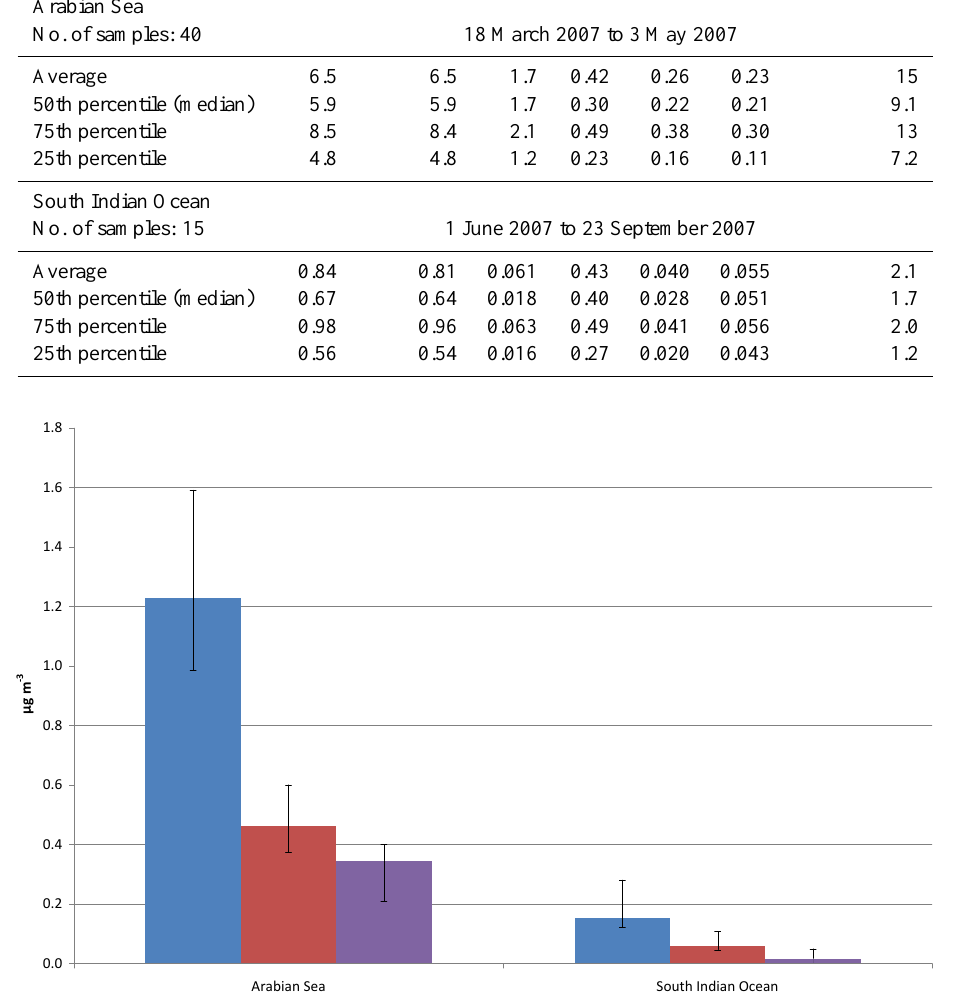
Fig. 6. Uncorrected absorption coefficient values (blue), compared with two different methods of correction (optical correction=dark red and chemical correction=purple) implemented on the uncorrected values for the two data selections. Bars indicate 75 and 25 percentiles. The coefficient of variation of the method is included in the spread of the sample population indicated by the bars. BC mass concentrations were derived using a mass absorption cross-section od 10 ± 1m 2 g − 1